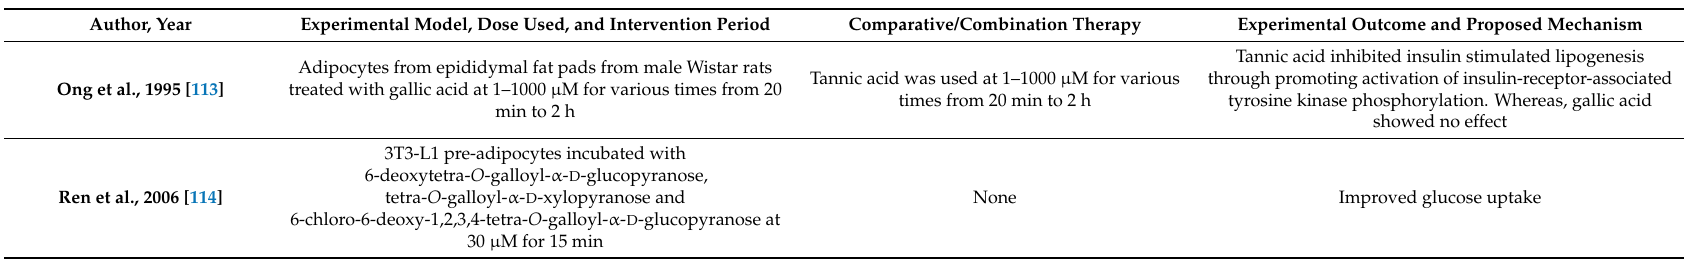
Table 2. Overview of studies reporting on the ameliorative effect of gallic acid derived compounds against obesity-associated